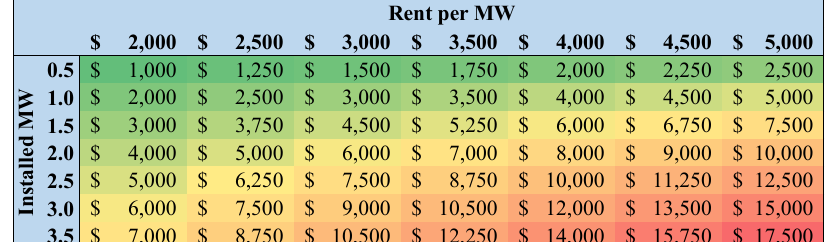
Table 2. Annual rental income from one wind turbine considering different NPC and negotiated rental rates (USD/MW).